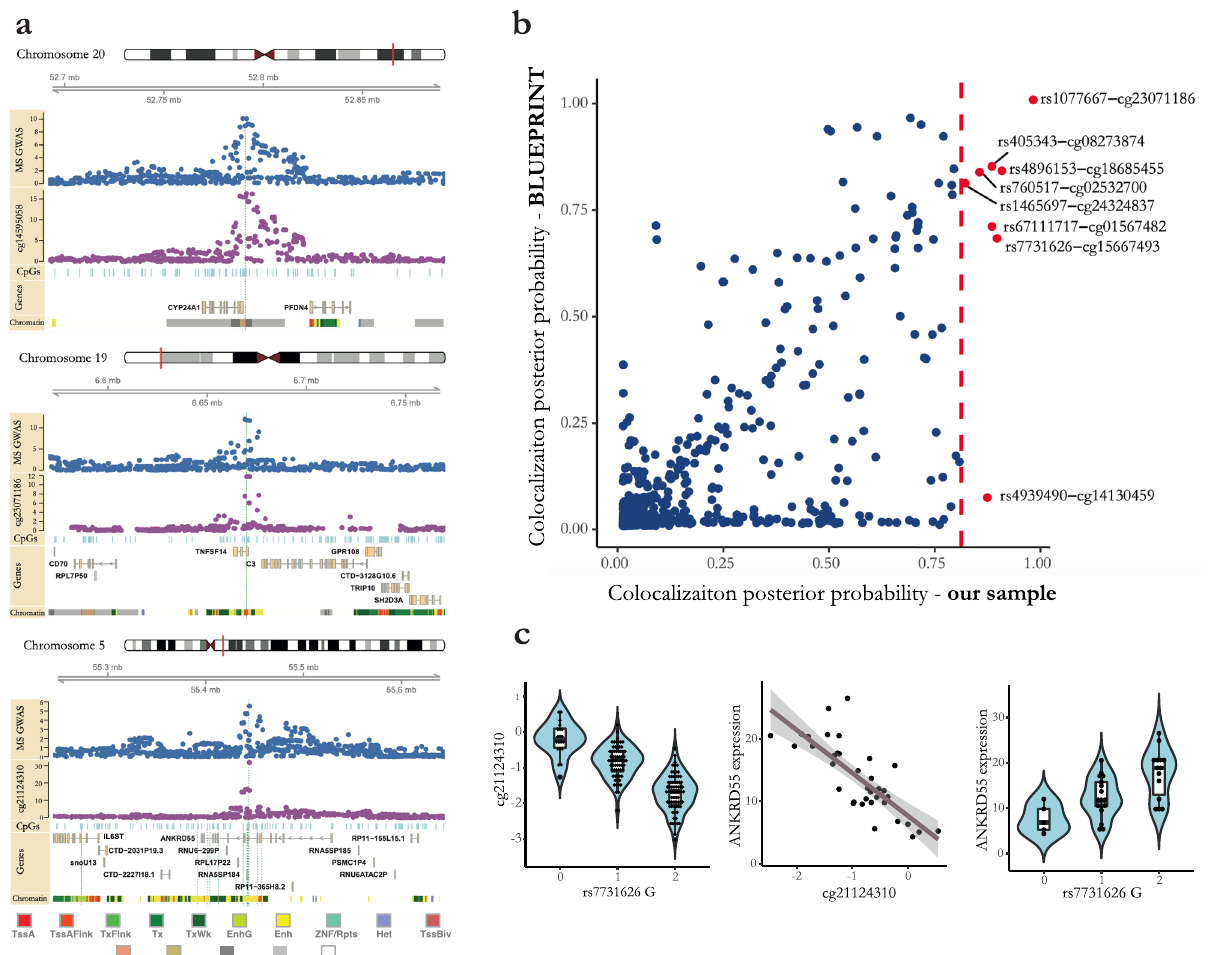
Fig. 2 Colocalized cis -mQTL effects of MS susceptibility loci. a The top 3 colocalized MS- cis -mQTL effects are illustrated (posterior probability >0.95 for colocalization between MS susceptibility and ≥ 1 cis -mQTL effect). The MS GWAS rows (blue dots) show -log( p -value) of association between SNPs and MS susceptibility in the discovery phase of the 2019 IMSGC GWAS. CpG rows (plum dots) show -log( p -value) of association between SNPs and the speci fi ed cis -CpGs methylation levels. Locations of the local CpGs measured with the In fi nium MethylationEPIC kit are shown using light blue vertical lines. Gene exon/intron positions are based on Ensembl 93. Chromatin state annotations for CD4 + T cells are downloaded from the Roadmap Epigenomics Project (sample #E043). Green vertical lines represent the genomic location of the colocalized CpGs: Long vertical lines traversing all rows represent the top speci fi ed CpGs, while other vertical lines represent the additional colocalized cis -mCpGs with posterior probability >0.8. All genomic positions are in GRCh37 (hg19) coordinates. b Comparison between MS- cis -mQTL colocalization posterior probabilities using mQTL summary statistics from our study and BLUEPRINT for the available common CpGs. Vertical red line represents the threshold for high colocalization posterior probability in our study (i.e., 0.8). c The cis -mQTL, cis -eQTL, and CpG-mRNA association for the chromosome 5 top MS- cis -mQTL colocalized effect ( n = 156, 36 and 36, respectively). Methylation levels are shown in M-values. Gene expression values are in TPM. Boxplot center lines represent median; the lower and upper hinges correspond to the 25th and 75th percentiles; the lower/upper whisker extends from the hinge to the smallest/largest value no further than 1.5× inter- quartile range. Error band represents 95% con fi dence